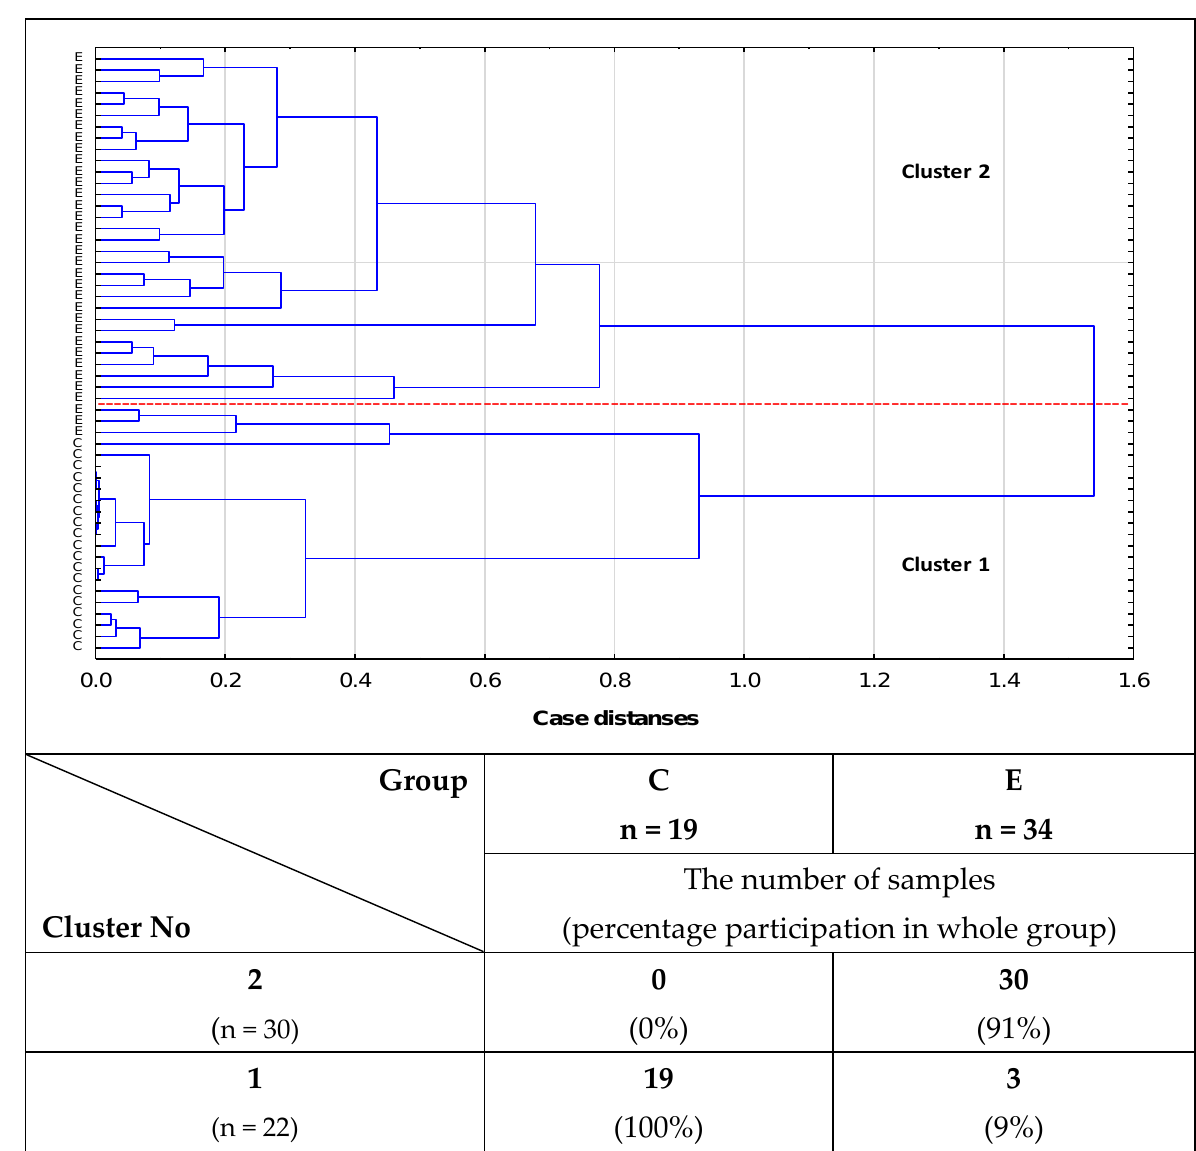
Figure 5. Dendrogram of cluster analysis for relative reactivities of isolated IgG with lectins in women with advanced endometriosis and healthy subjects. Cluster analysis was performed only for parameters for which the AUC value was high (>0.9) in ROC curve analysis, and which significantly differentiated patients with advanced endometriosis from healthy women. Each sample is represented by a vector of four features: MPL, VVL, Jacalin, and PHA-L relative reactivities with i-IgG